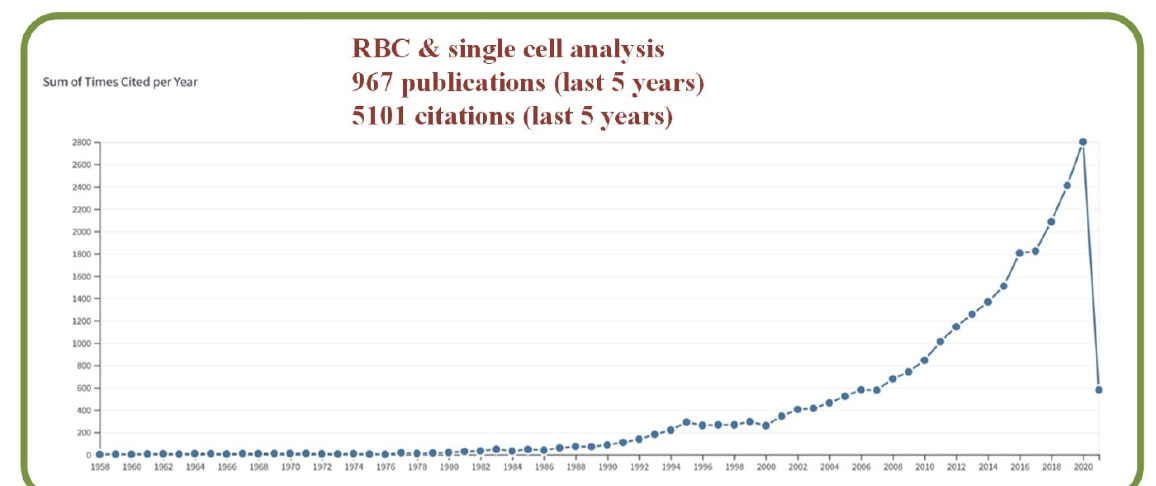
Figure 1. Graph created with the Clarivate Analytics citation report, with a topic search of “RBC” AND “single cell analysis”.